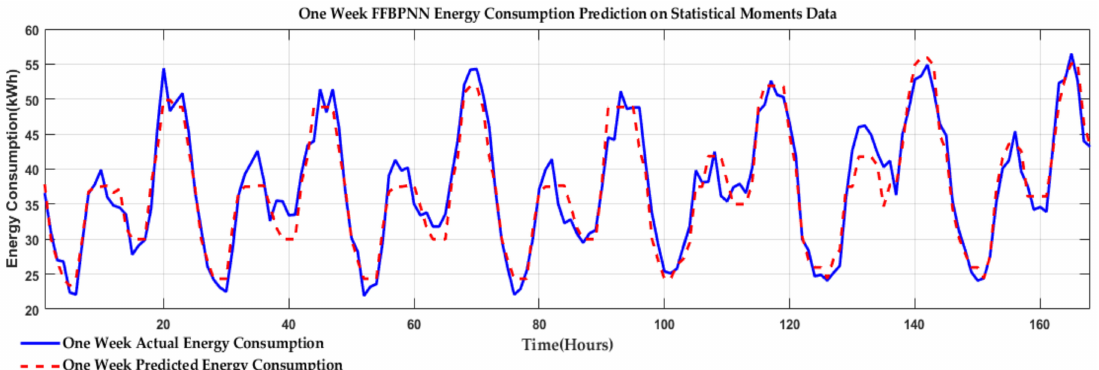
Figure 20. One week hourly energy consumption prediction using FFBPNN on statistical moments data.